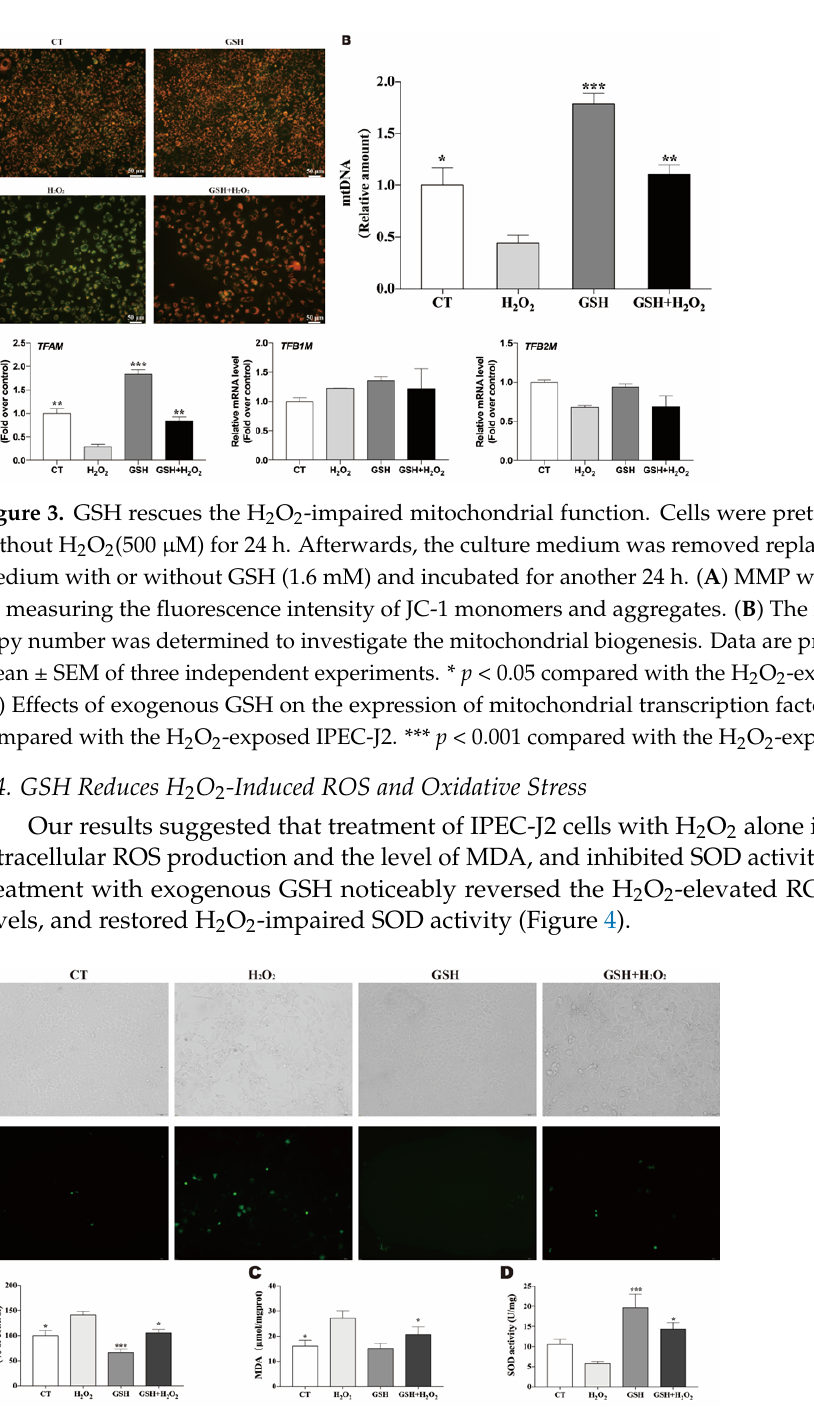
Figure 4. GSH attenuates H 2 O 2 -induced oxidative stress. Cells were pretreated with or without H 2 O 2 (500 µ M) for 24 h. Afterwards, the culture medium was removed replaced with fresh medium with or without GSH (1.6 mM) and incubated for another 24 h. ( A ) After treatment, the normal image of the cells in the same field of view and the fluorescence image showing the level of ROS were captured. ( B ) ROS generation determined by measuring the fluorescence intensity of an oxidation-sensitive fluorescein DCFH-DA. Data represent means± S.E.M. (n = 6) and differences between mean values were assessed by one-way ANOVA. *** p < 0.001 indicate the significant difference compared with H 2 O 2 -treated group. ( C ) Quantification of MDA generation. ( D ) Quantification of SOD activity. Values are presented as the mean ± SEM ( n = 3). * p < 0.05 compared with the H 2 O 2 -exposed IPEC-J2. *** p < 0.001 compared with the H 2 O 2 -exposed